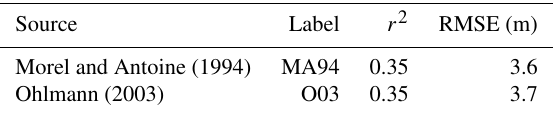
Figure 5. (a) Location of each profile for glider SG579 (diamond), float 629 (square), float 630 (circle), and float 631 (triangle) across the southern Bay of Bengal coloured by the observed h 2 value. The ESA OC-CCI version 3.1 satellite composite of 4km chlorophyll a concentration for the month of July 2016 is shown. (b) The h 2 vari- ability with longitude across the basin for glider SG579 (black di- amond), float 629 (blue square), float 630 (green circle), and float 631 (red triangle). The grey solid line represents the mean h 2 value binned at 0.5 ◦ intervals. Table 1. Summary of determination coefficients ( r 2 ) and root mean square errors (RMSEs) when comparing parameterizations to ocean-glider-observed (SG579) scale depth, h 2 , and average 0– 30m mixed-layer chlorophyll concentrations (Fig.